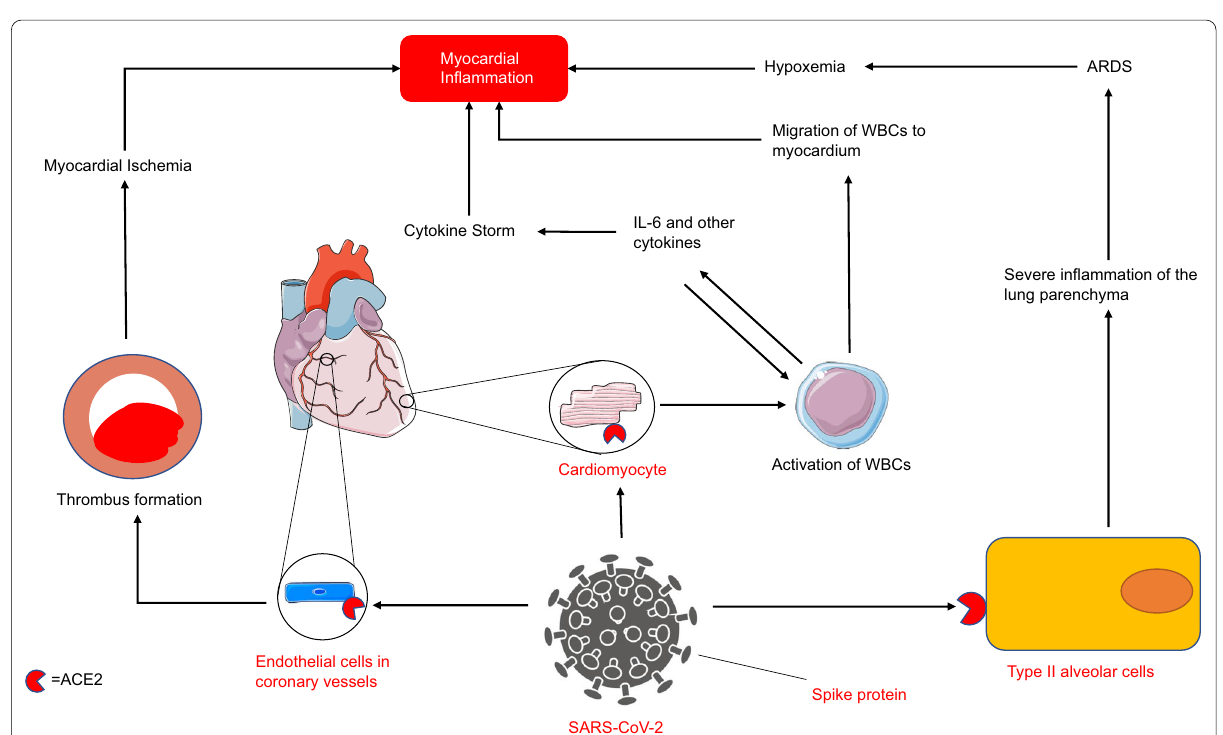
Fig. 1 Pathophysiology of COVID‑19‑induced myocarditis. SARS‑CoV‑2 uses the Spike protein to bind to and enter a variety of cells including type II alveolar cells, cardiomyocytes and endothelial cells. Myocardial inflammation results from the combination of hypoxemia, thrombus‑induced ischemia and the migration of proinflammatory cytokines and cells to the area. ACE2 distress syndrome;